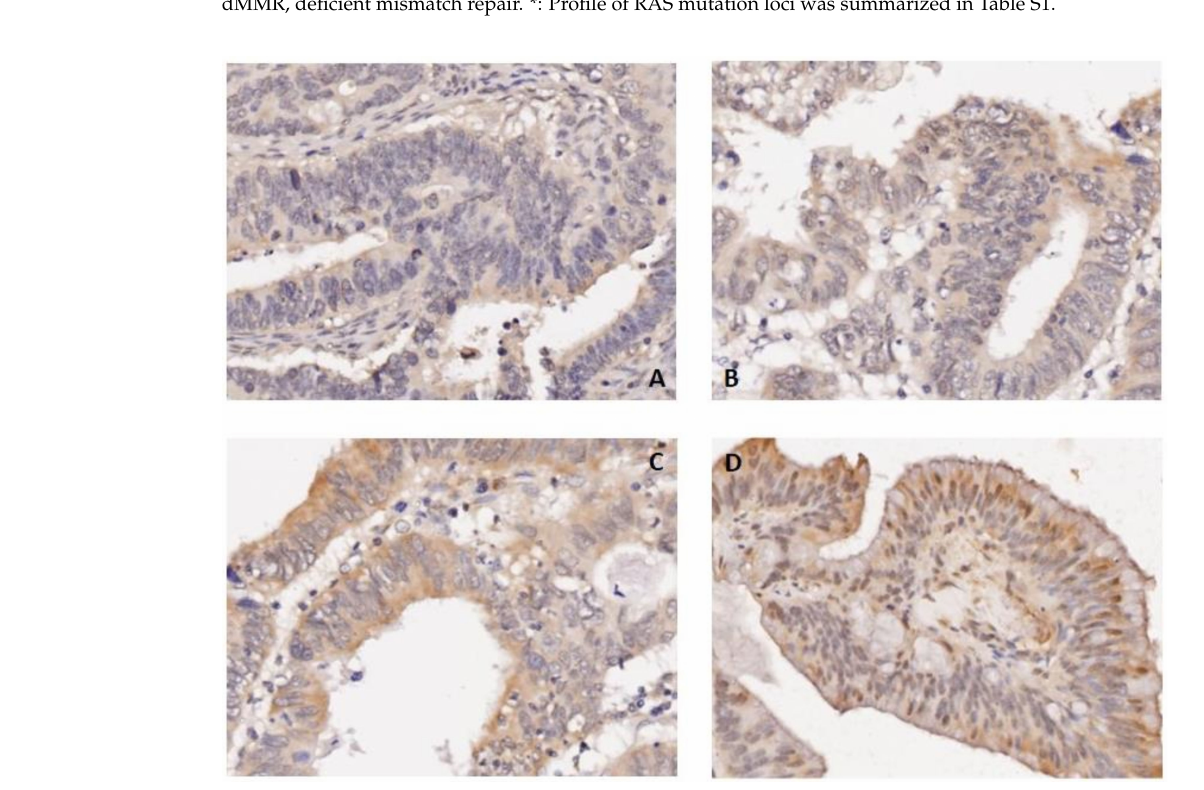
Figure 1. Representative images of IHC staining of CUL9. Tumor tissue with staining intensity from negative to strong positive ( A – D ) is presented successively. Magnification of all images, ×